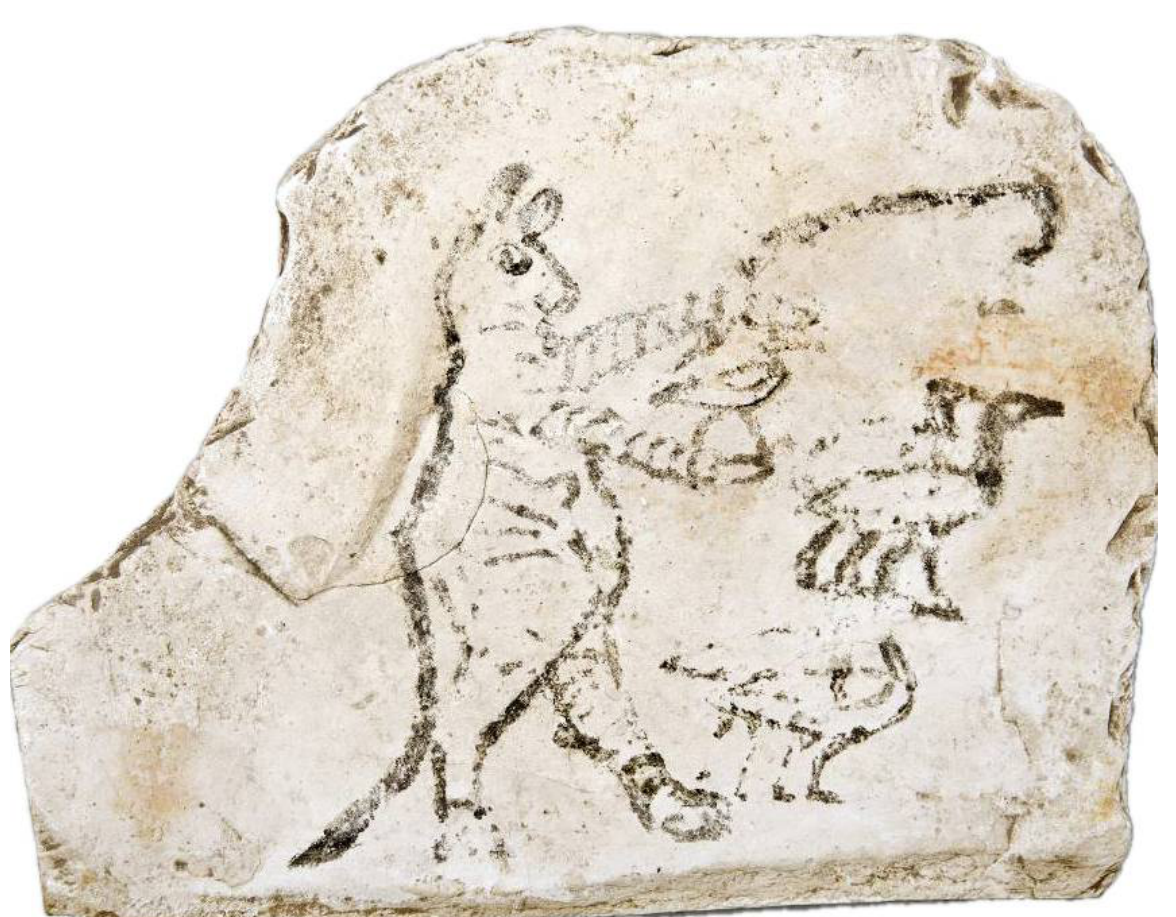
Figure 2. Cat herding geese (MM inv. no. 14051), limestone flame, Deir el-Medina, Ramesside period (Image courtesy of the Medelhavsmuseet, Stockholm).